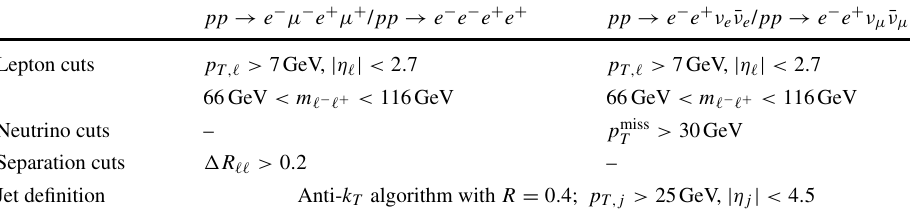
Table 10 Default setup of fiducial cuts for W + W − and W ± Z production